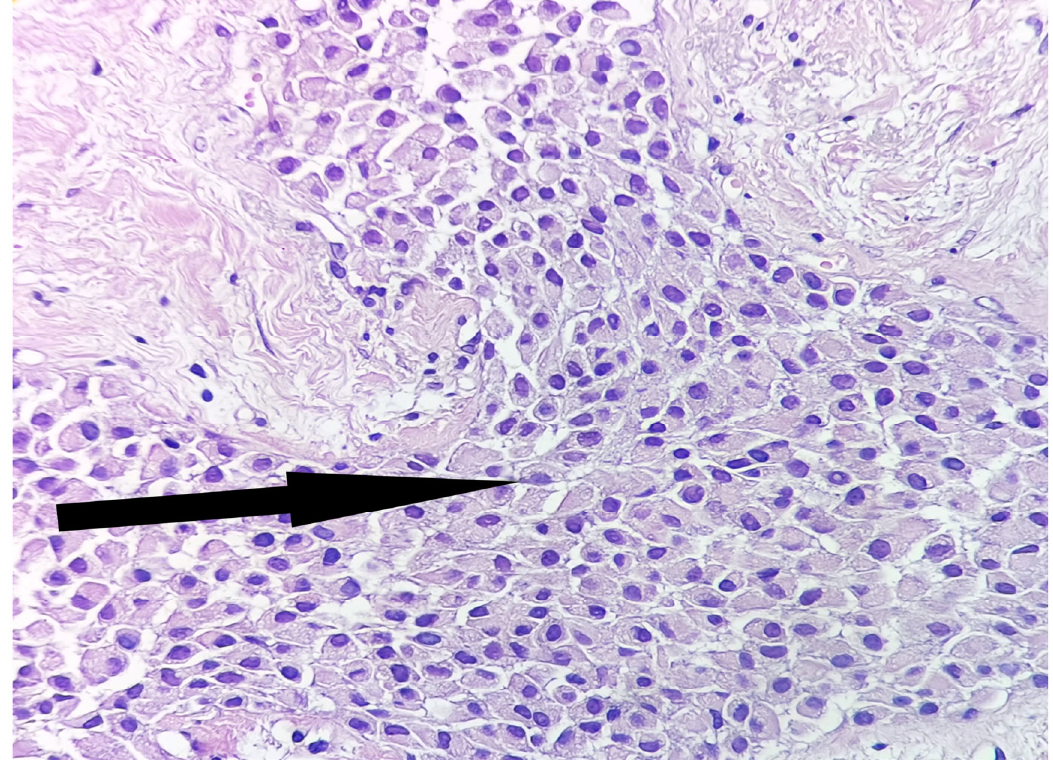
Figure 4. Tumor proliferation with an infiltrative aspect, consisting of plasmacytoid tumor cells, arranged in solid nests—black arrow (HE, ob.20×) .